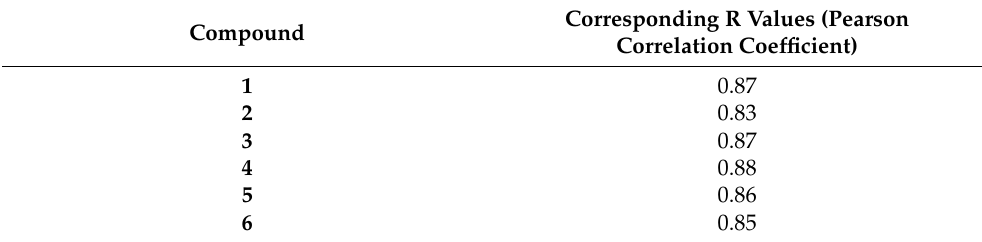
Figure 9. Co-localized images of A549 cells incubated with compounds ( a ) 1 , ( d ) 2 , ( g ) 3 , ( j ) 4 , ( m ) 5, and ( p ) 6 (10 µ M) and Mito Tracker Red (200 nM) ( b ) 1 , ( e ) 2 , ( h ) 3 , ( k ) 4 , ( n ) 5 , and ( q ) 6 for 30 min. The merged images co-cultured with ( c ) 1 , ( f ) 2 , ( i ) 3 , ( l ) 4 , ( o ) 5 , ( r ) 6 . The excitation wavelength of compounds 1 – 6 was 405 nm. The excitation wavelength of Mito Tracker Red was 578 nm. Table 3. Corresponding R values of compounds 1 – 6